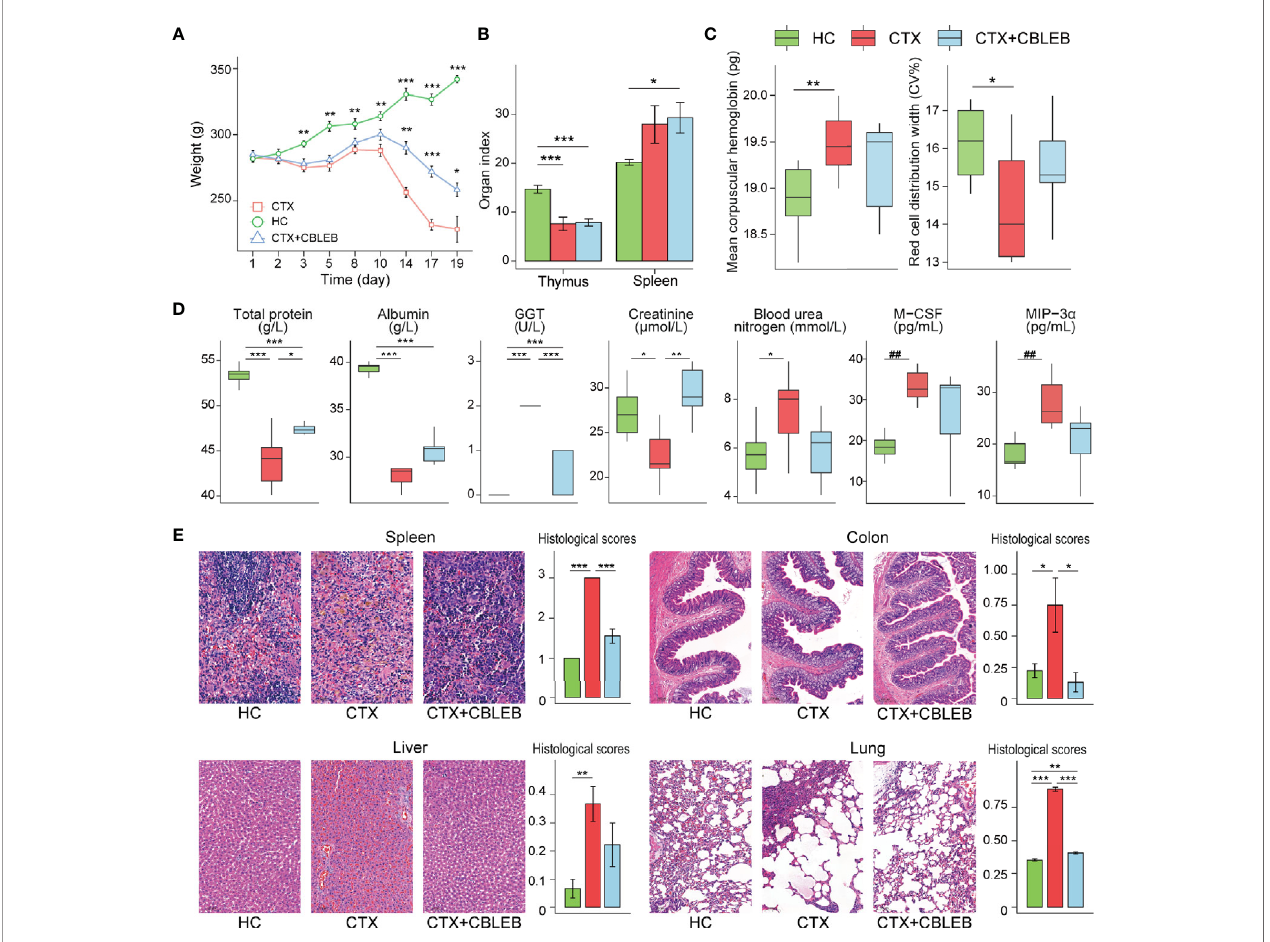
FIGURE 1 | CBLEB reduces cyclophosphamide-induced death, weight loss, immune dysfunction, and organ damage. (A) Weight plot (* P < 0.05; ** P < 0.01; *** P < 0.001 versus the CTX group), (B) thymus and spleen indexes, (C) mean corpuscular hemoglobin and red cell distribution width in the serum samples, (D) concentrations of total protein, albumin, GGT, creatinine, blood urea, M-CSF, and MIP-3 a in the serum samples; (E) representative images of the spleen, colon, liver, and lung samples stained by H&E and the corresponding histological scores in the CTX (n = 6), CTX+CBLEB (n = 9), and HC (n = 9) groups. * P < 0.05; ** P < 0.01; *** P < 0.001; ## P adj <